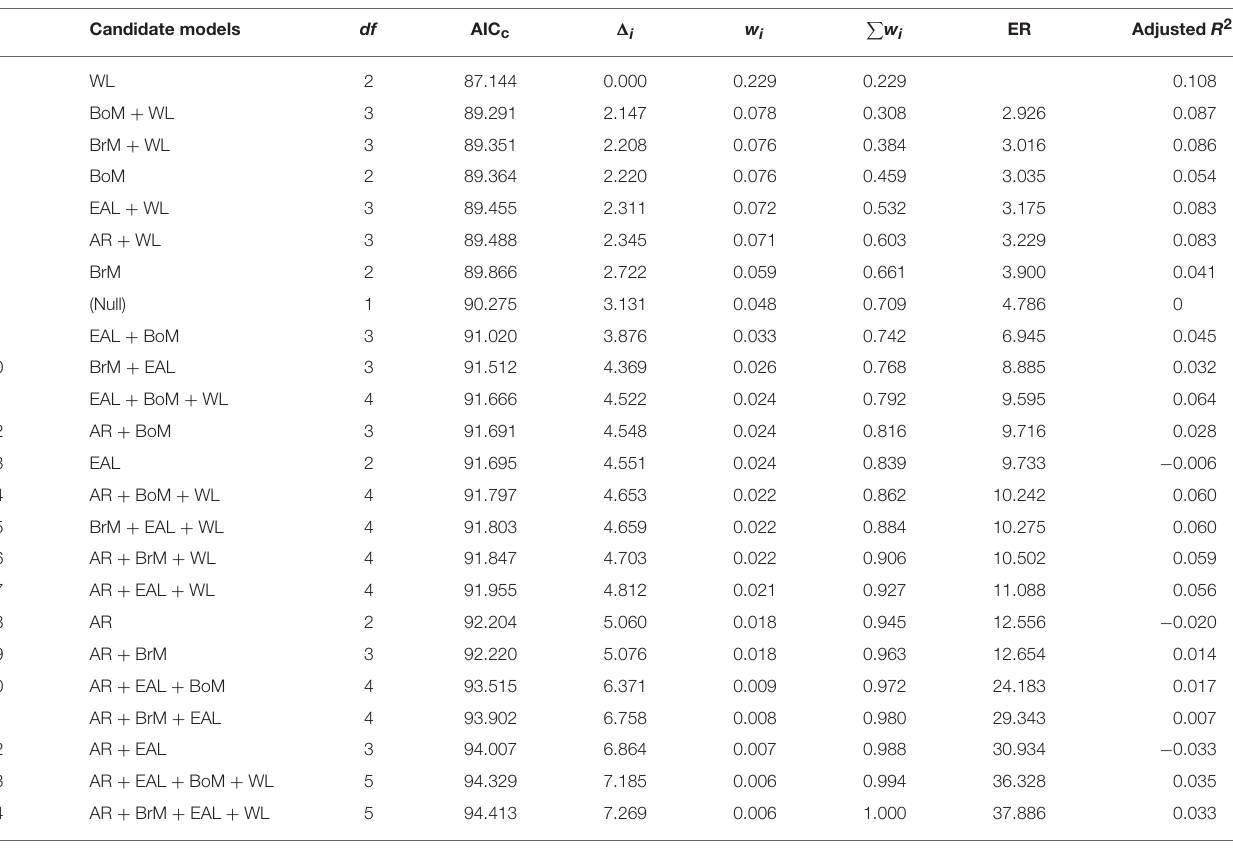
TABLE 2 | Summary of 24 candidate models (but excluding the ones in which pairs of variables had correlations ≥ 0.90) assessing the effects of body mass (BoM), eye axial length (EAL), brain mass (BrM), wing loading (WL), and wing aspect ratio (AR) on the frequency of bird strikes following different criteria: Akaike’s Information Criterion